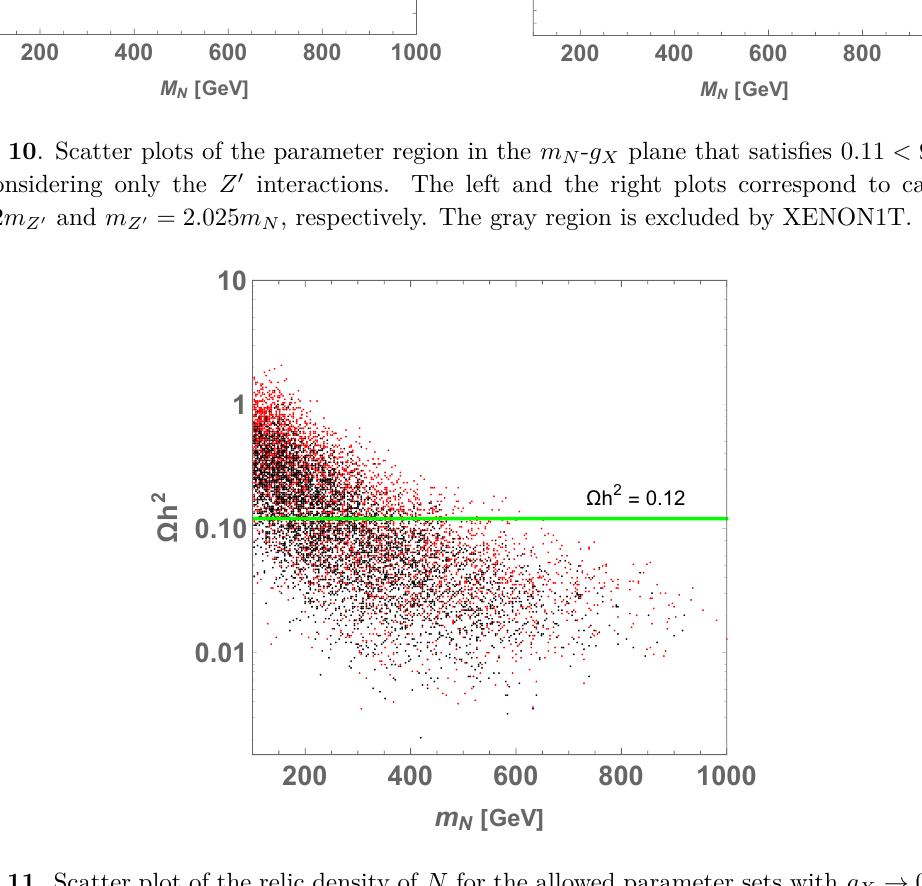
Figure 11 . Scatter plot of the relic density of N for the allowed parameter sets with g X → 0 . The black and red points denote the results of NO and IO,